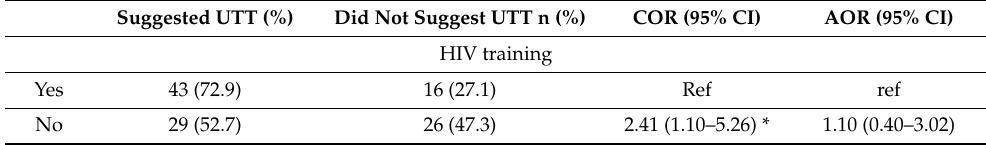
Table 6. Predictors of positive perceptions towards